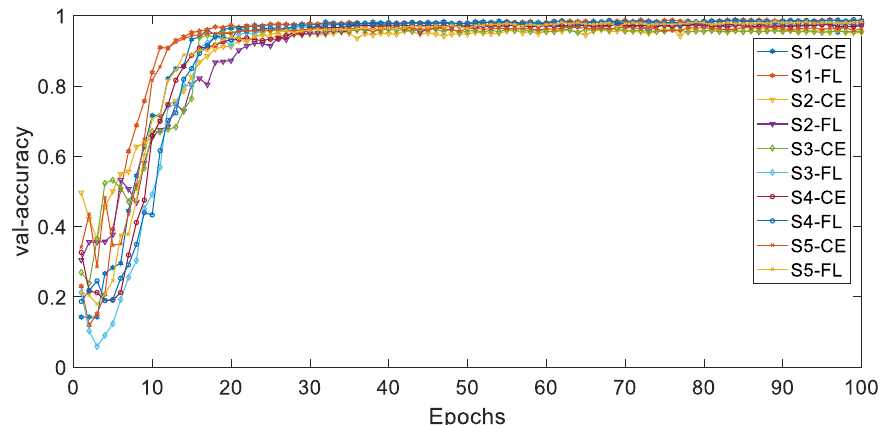
Figure 5. The curve of accuracy with validation set.